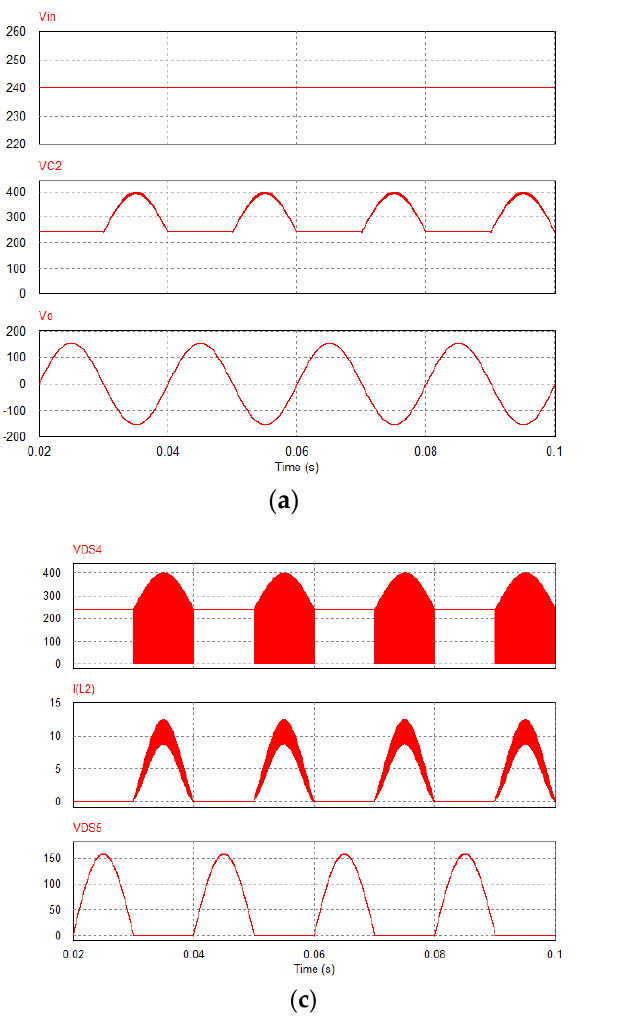
Figure 6. Simulation results with V in = 60 V: ( a ) the input, output and capacitor C 2 voltages, ( b ) the voltage stress on switches S 1 , S 2 , and the current of inductor L 1 , ( c ) the voltage stress on switches S 4 , S 5 , and the current of inductor L 2 , and ( d ) the voltage stress on diodes D 1 , D 2 , D 3 and the voltage stress on switch S 3 .